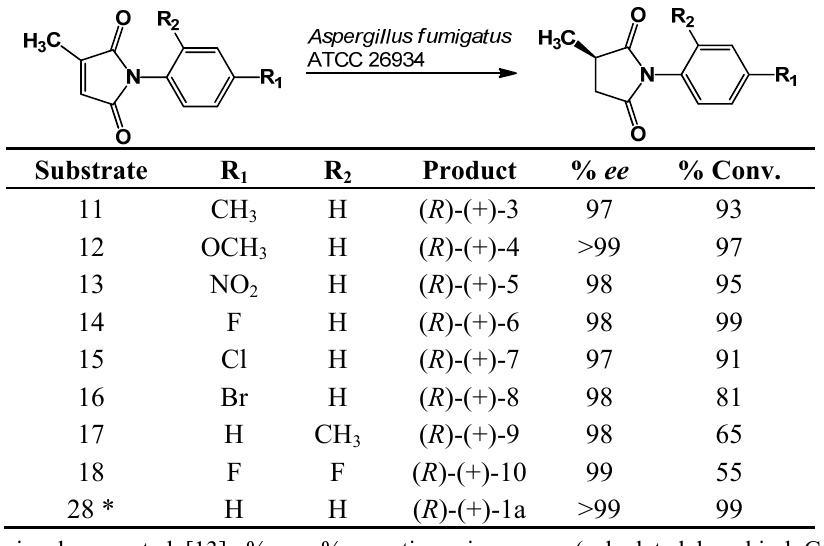
Table 1. Biotransformation of 3-methyl- N- arylmaleimides 11 – 18 to (3 R )-(+)-methyl- N- arylsuccinimides 3 – 10